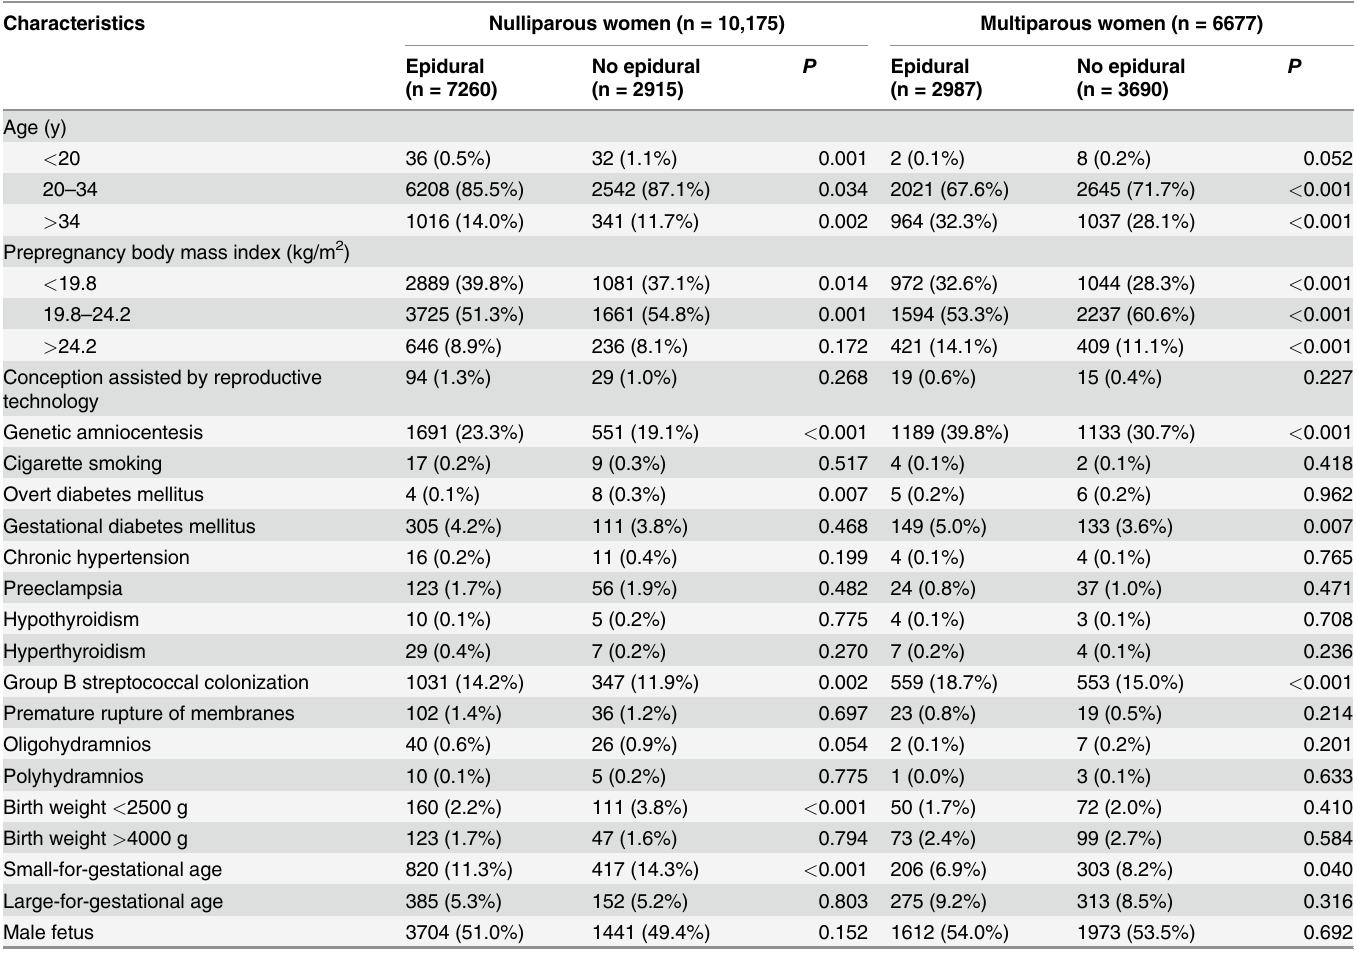
Table 1. Maternal demographic and pregnancy characteristics of the nulliparous and multiparous women with or without the use of epidural anal- gesia during labor.